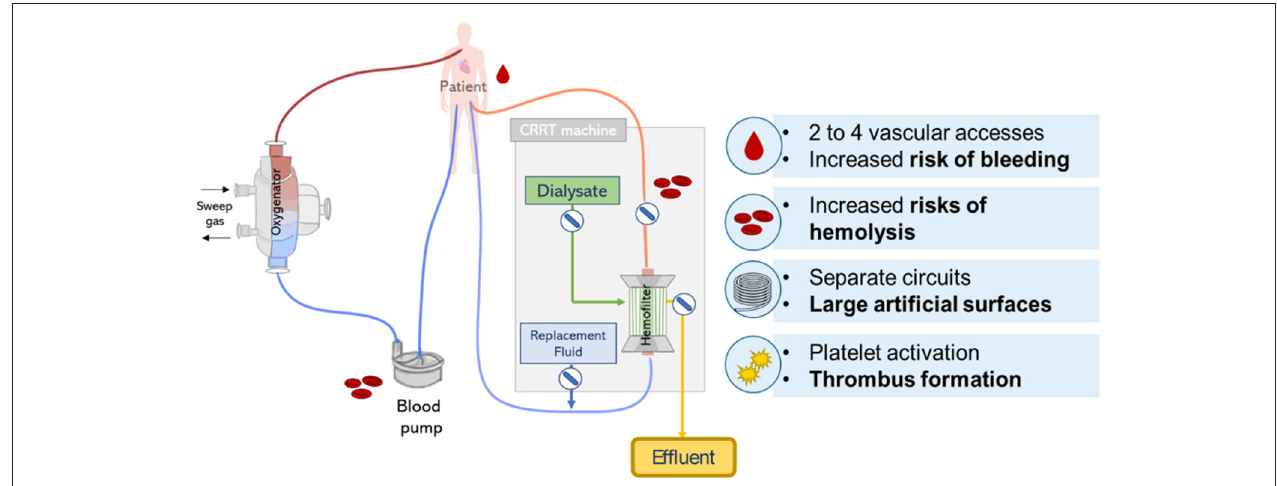
FIGURE 9 | Lung and kidney support provided by parallel CRRT and ECMO circuits. Scheme represents possible circuit derived complications including risks of hemolysis, bleeding, and thrombus formation.